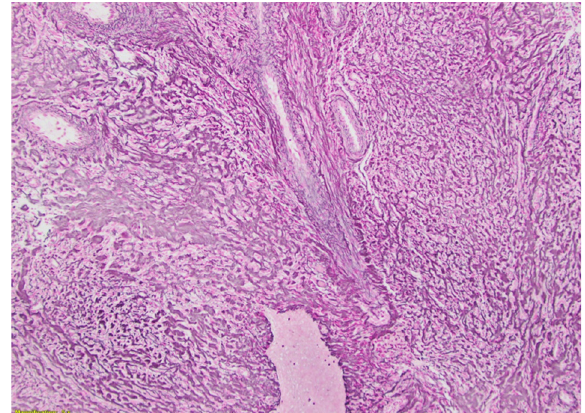
Reticulin stain ×100 highlights the